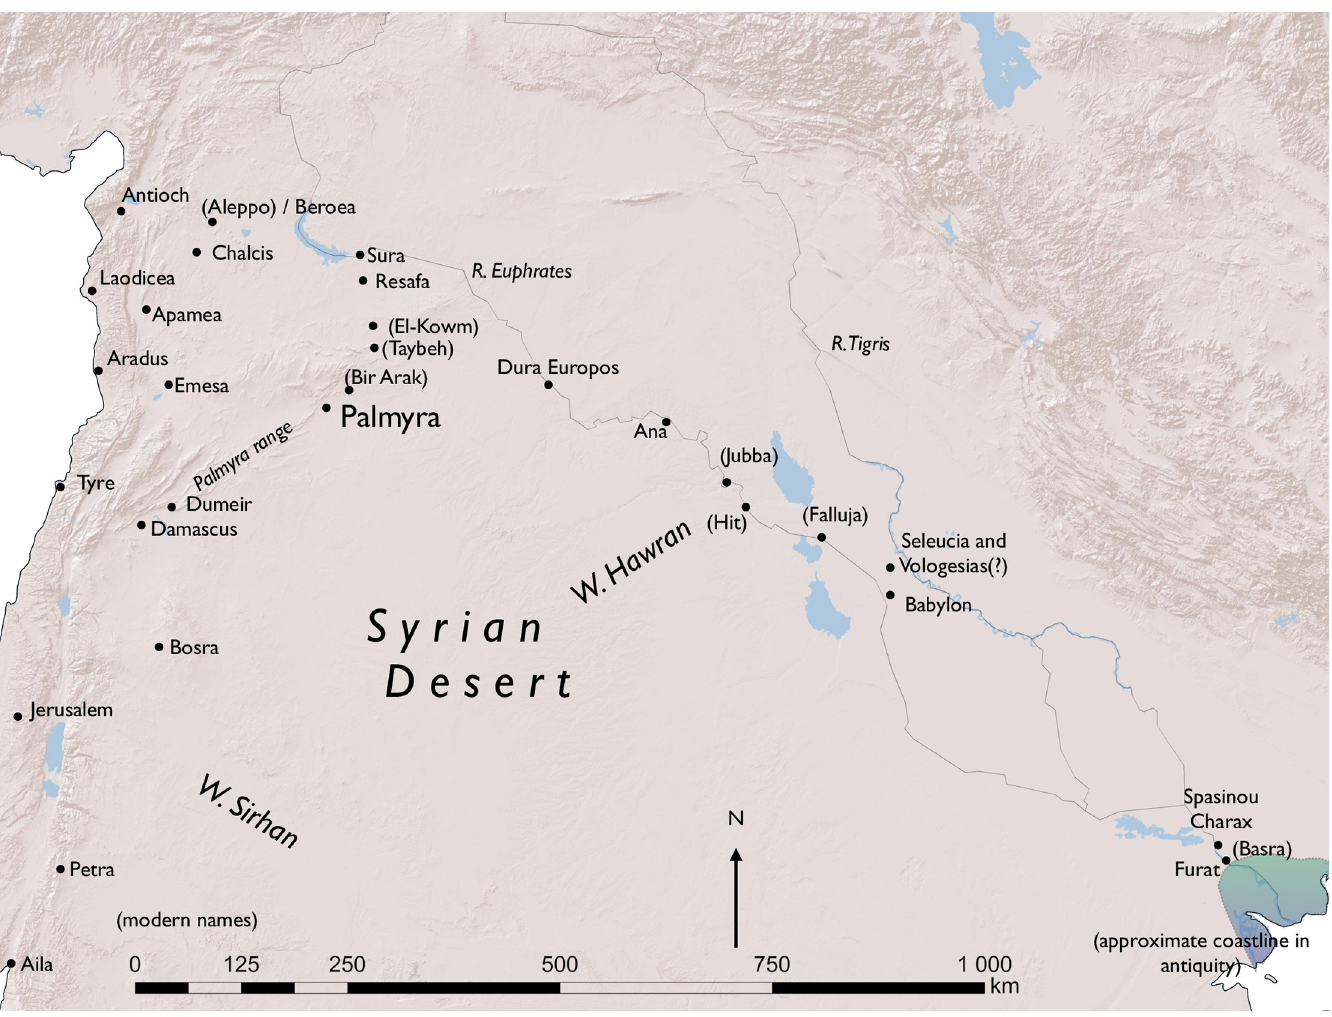
Fig 1. Map of Palmyra and the surrounding region. Reprinted with permission by professor Eivind H. Seland under a CC BY license. Basemap: ESRI.